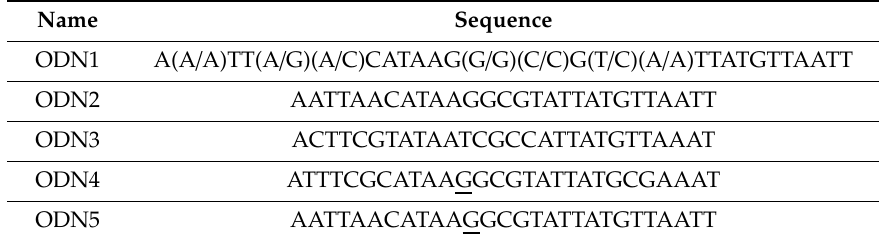
Table 1. Oligonucleotides used in the binding and cleavage assays.